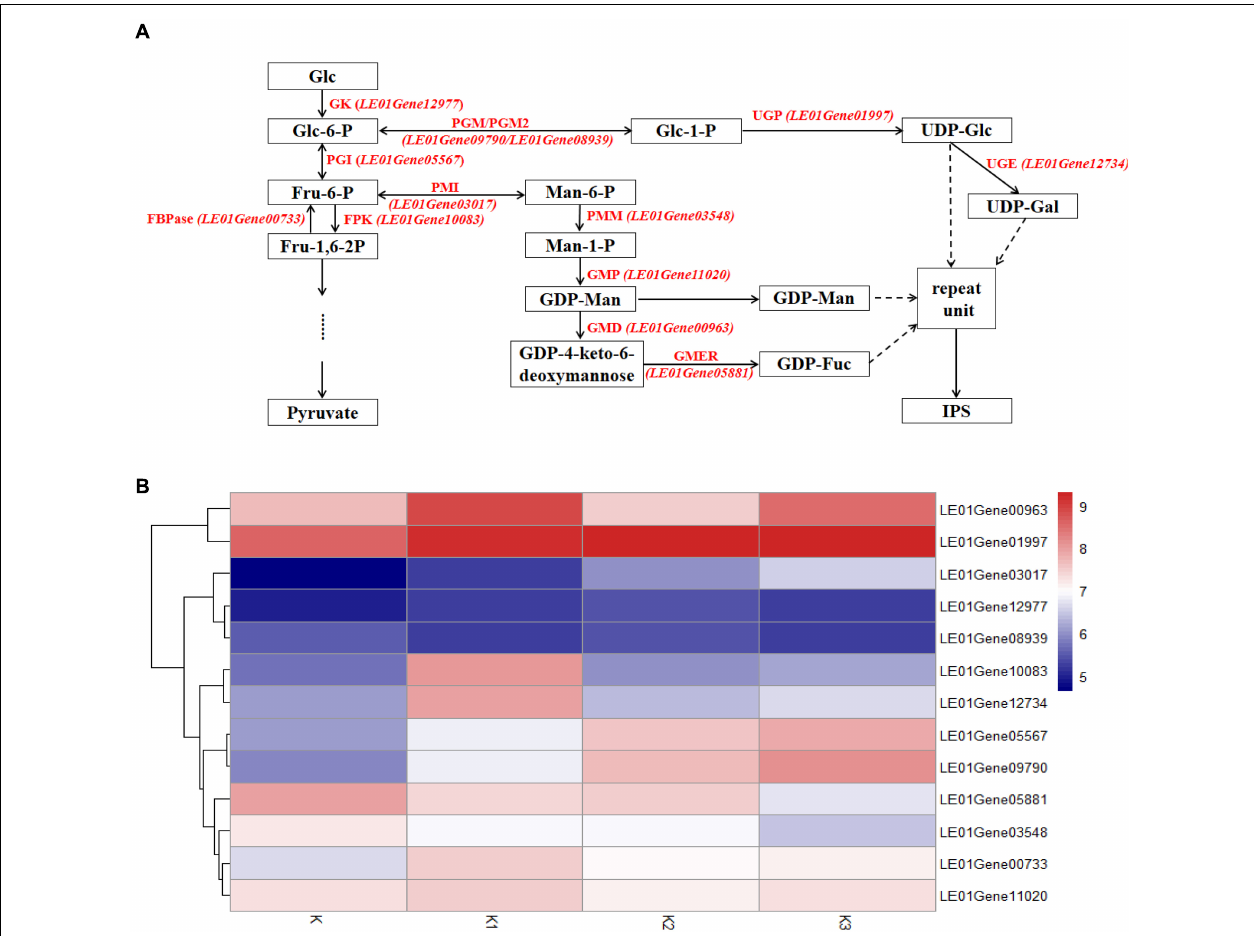
FIGURE 8 | Expression of related genes and hypothesized nucleotide sugar precursors biosynthetic pathways in L. edodes . (A) The mushroom nucleotide sugar precursor biosynthetic pathways modified from reference. GK, Glucokinase; PGI, Phosphoglucose isomerase; FBPase, Fructose-1,6-biphosphatase; FPK, Phosphofructokinase; PMI, Phosphomannose isomerase; PMM, Phosphomannose mutase; GMP, GDP-Man pyrophosphorylase; GMD, GDP-Man dehydratase; GMER, GDP-4-keto-6-deoxymannose epimerase/reductase; PGM/PGM2, Phosphoglucose mutase; UGP, UDP-Glc pyrophosphorylase; UGE, UDP-Gal-4-epimerase. (B) Heatmap analysis of expressed mRNA involved in mushroom nucleotide sugar precursor biosynthetic